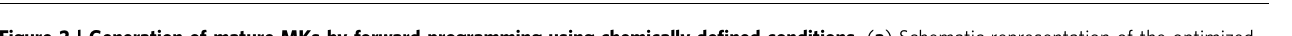
Figure 2 | Generation of mature MKs by forward programming using chemically defined conditions. ( a ) Schematic representation of the optimized MK-FOP protocol. Viral transduction at day 0 concurrent with embryoid body generation and mesoderm induction for 2 days was followed by a period of culture in an MK induction medium (TPO þ SCF) for 8 days. Embryoid bodies showing cystic structures and actively growing cell aggregates were dissociated to single cells at day 10 and further differentiated to mature MKs (TPO þ IL1 b ) until day 20 post transduction. ( b ) Time course of fopMK differentiation showing MK lineage commitment (%CD41a þ cells) and MK maturation (%CD42a þ cells) from whole culture (mean ± s.e.m. from hiPSC lines #1 and #2; n ¼ 2 (day0–10); n ¼ 6 (day14–22)). Representative flow cytometry dot plots for CD41a and CD42a expression are shown below. ( c ) The MK fold increase at day 20 relative to the day 0 hiPSC input is shown on a logarithmic scale for the hiPSC lines #1–4 differentiated by forward programming (fopMK: mean ± s.e.m.; n ¼ 14, 7, 3, 5 respectively) or directed differentiation (hiPSCs#1 and #2; ddMK: mean ± s.e.m.; n ¼ 3,2 respectively). ** P o 0.01 and * P o 0.05 by two-tail t -test. ( d ) Representative histograms of the expression of major platelet receptors detected by flow cytometry are shown for day 20 fopMKs (red line) and day 10 cbMKs (blue line) against isotype control (grey shade). ( e ) The morphology of day 20 fopMKs and day 10 cbMKs was analysed by modified Romanowsky staining on fixed cells. Arrowheads point to multinucleated cells. Scale bars, 25 m m. ( f ) Cell size distribution from fopMK and cbMK cultures is shown as box plots: centre lines show the medians; box limits indicate the 25th and 75th percentiles; whiskers extend 1.5 times the interquartile range from the 25th and 75th percentiles, outliers are represented by dots ( n ¼ 50, 74 respectively; ** P o 0.01 by two-tail t -test). ( g ) Cell ultrastructure of fopMKs and cbMKs was visualized by transmission electron microscopy. dms, demarcation membrane system; gr, granules; mvb, multi-vesicular body; mit, mitochondria. Scale bars, 2 m m. ( h ) Representative confocal pictures of fopMKs immunostained for major alpha-granule proteins (thrombospondin, fibrinogen, P-selectin and Von Willebrand Factor; iPSC#3 fopMKs, day 40). Scale bars, 25 m